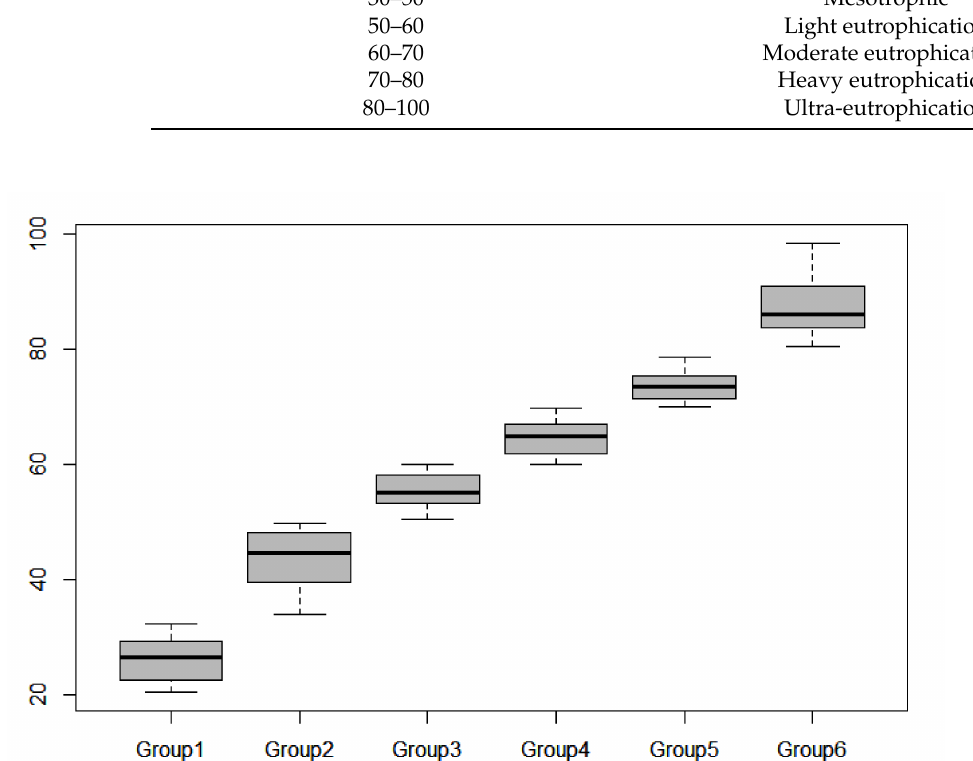
Figure 5. Distribution of CDI values along the water quality gradient (group 1: oligotrophic; group 2: mesotrophic; group 3: light eutrophication; group 4: moderate eutrophication; group 5: heavy eutrophication; group 6: ultra-eutrophication). The CDI was more highly correlated with the conductivity, pH, TP, TN, COD, and TDS compared to the other diatom indices (Table 3). Table 3. Spearman correlations between the diatom indices and some physical–chemical